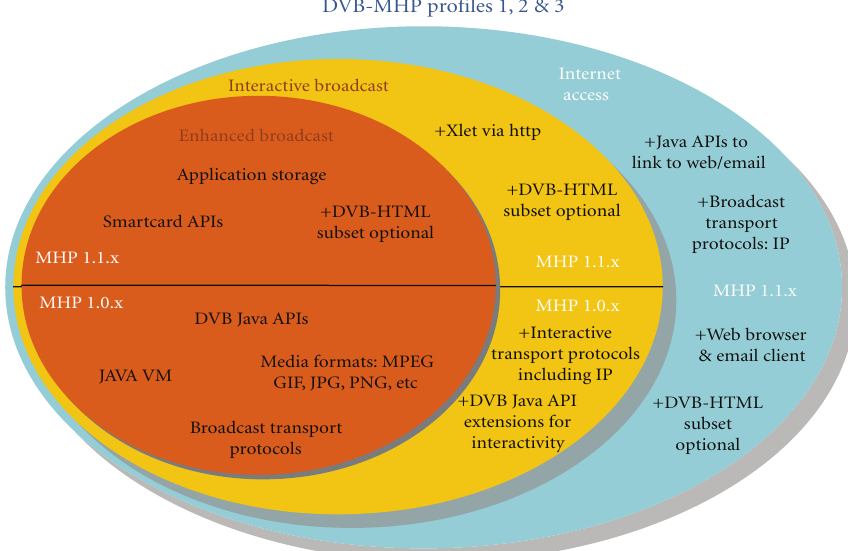
Figure 5: MHP Profiles